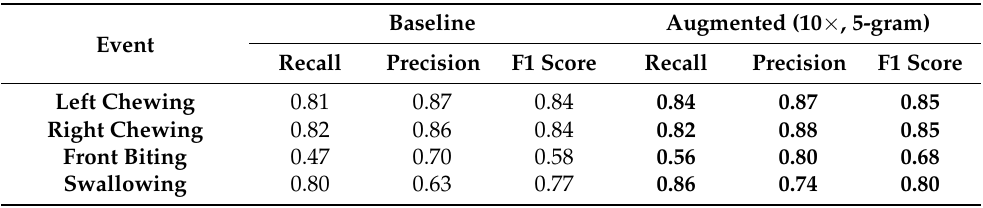
Table 5. Per-event detection performance by data augmentation (closed food and hybrid CTC/attention model): Five-class detection (left chewing, right chewing, front biting, swallowing, and others).